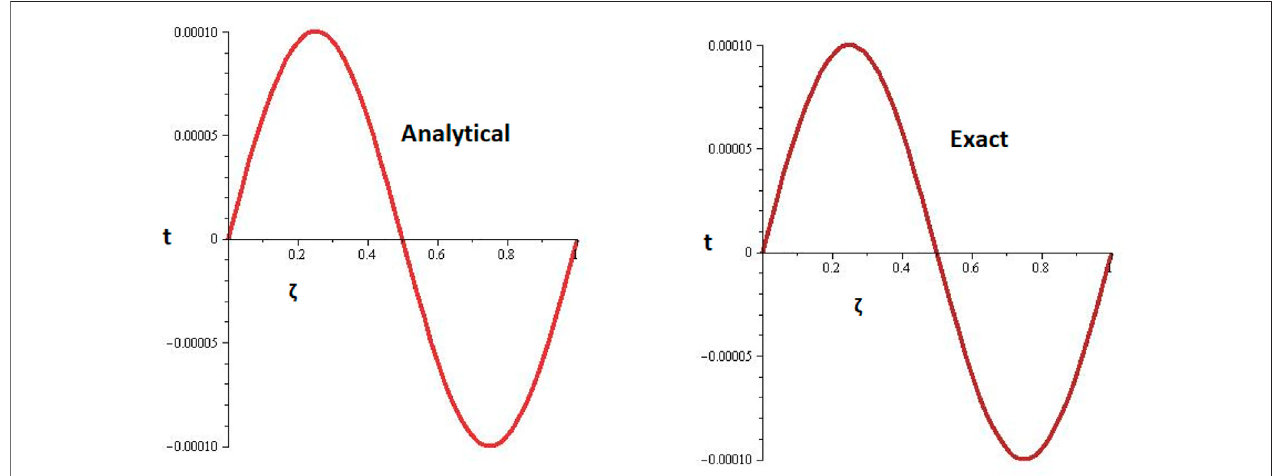
FIGURE 13 | 3D plots for the exact and analytical solution at γ =1 for Example 4